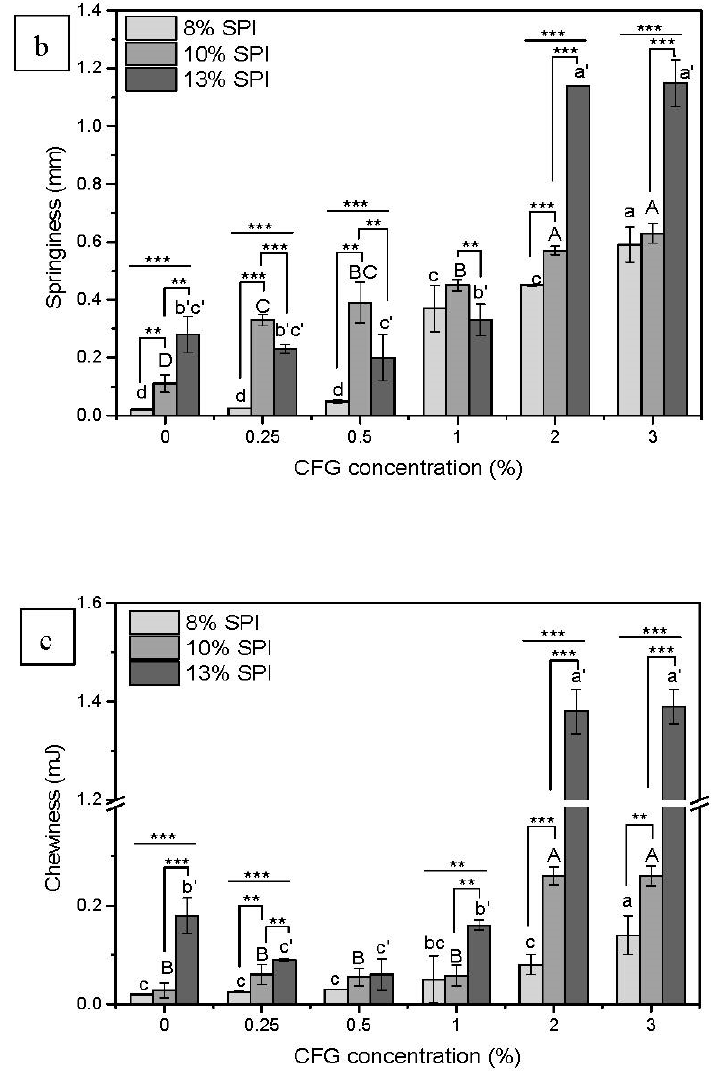
Figure 2. Textual properties of CFG-SPI DN hydrogels with various CFG/SPI proportions (( a ) Hardness; ( b ) Springiness; ( c ) Chewiness, the concentrations of CFG and SPI were 0%, 0.25%, 0.5%, 1%, 2%, 3% and 8%, 10%, 13% ( w / v ), respectively). Different letters (a–f, A–E, a ′ –e ′ ) indicate statistically significant differences between different CFG concentrations with SPI at a fixed concentration (8%, 10%, 13%, respectively) ( p < 0.05). A different number of * indicates that the mean values between the two columns differ significantly, i.e., *, **, *** indicate p < 0.1, p < 0.05, p < 0.001, respectively.